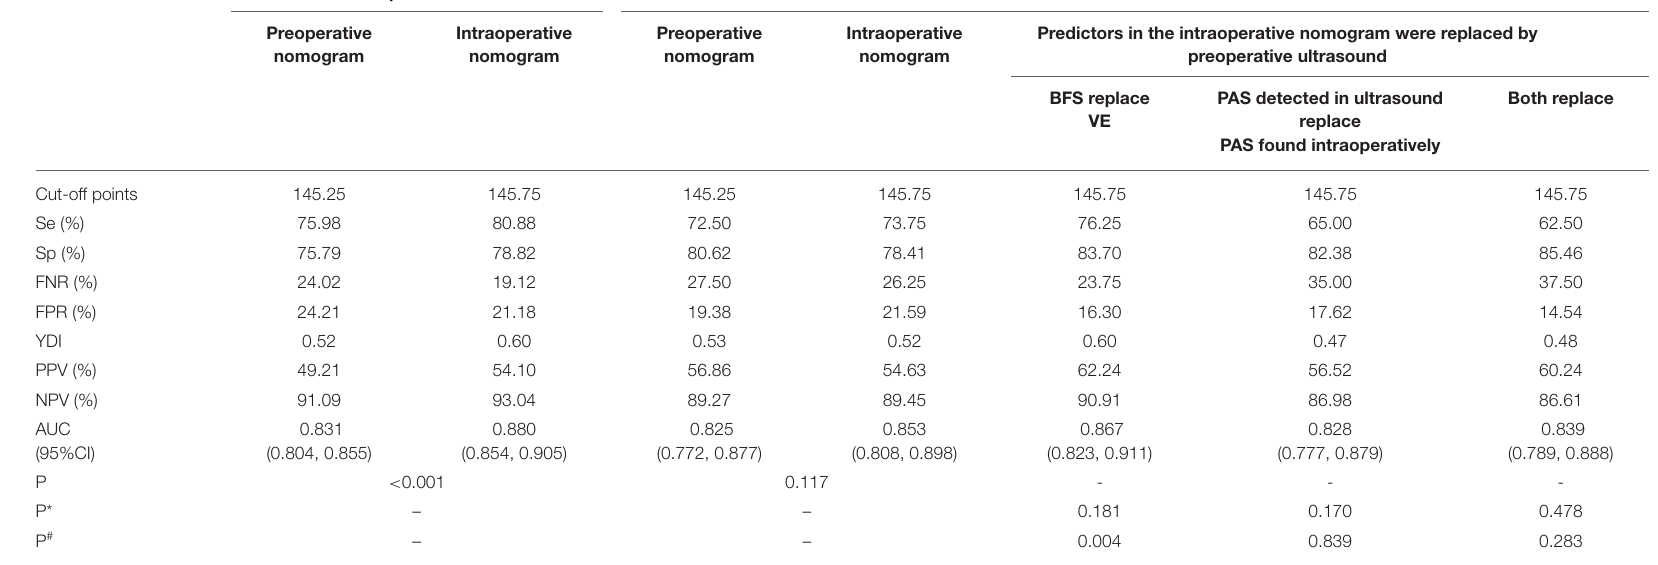
TABLE 4 | Prediction